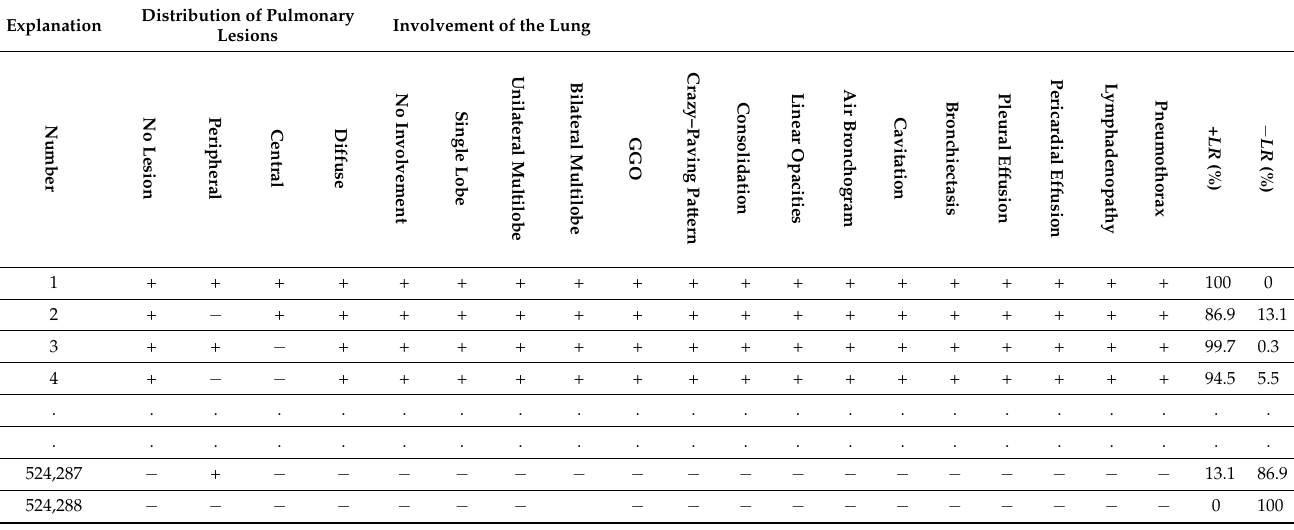
Table 5. All the probable predictions and explanations for COVID-19 patients according to their chest CT image.